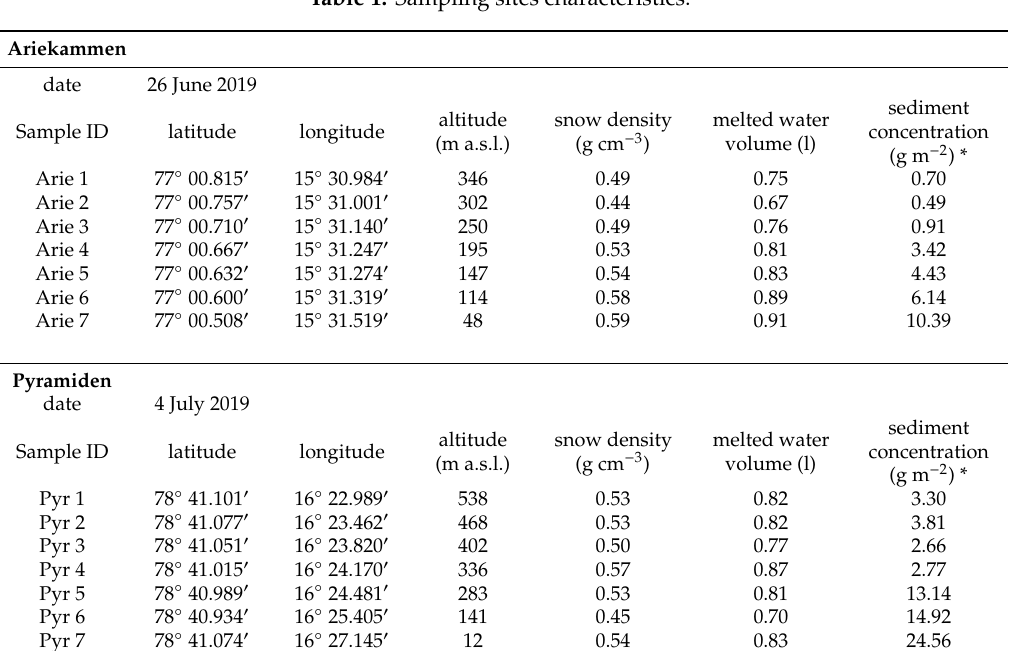
Figure 2. Ariekammen ( A) and Pyramiden ( B ) sampling sites with the continuous snowfields from where the samples were taken—marked with red arrows (photos by J. Kavan). Table 1. Sampling sites